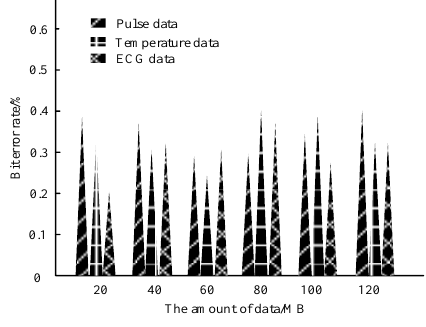
Figure 8. Statistical result of bit error